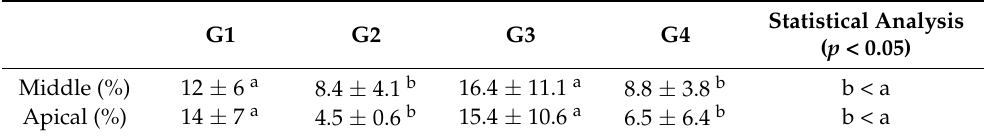
Table 2. Residual material percentages after all retreatment techniques. Different superscripted letters (a–d) indicate significant differences between the different groups ( p < 0.05). Group 1 (G1): D-Race; Group 2 (G2): D-Race followed by the use of XP–Endo Finisher R; Group 3 (G3): Protaper Universal Retreatment; and Group 4 (G4) Protaper Universal Retreatment followed by the use of XP–Endo Finisher R. G1